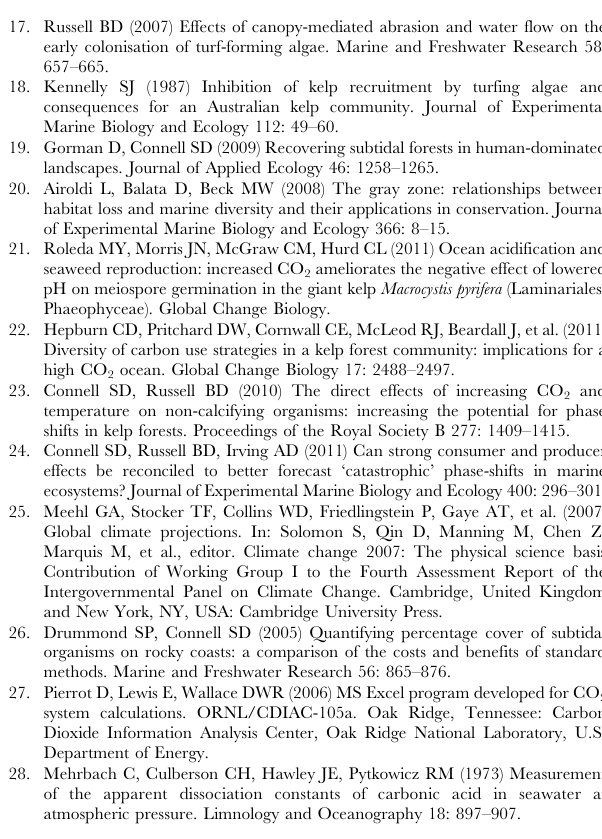
Figure S2 Carbonate chemistry parameters in field- based experimental mesocosms measured weekly from beginning to end of the experiment. pH (a), TA (b), p CO 2 (c), HCO 3 2 (d) in mesocosms under current CO 2 (filled circles) and future CO 2 (empty circles). Total Alkalinity (TA) and pH were measured weekly on eight occasions, from which concentrations ( m mol kg 2 1 ) of p CO 2 , and bicarbonate (HCO 3 2 ) were calculated. Values were calculated from measured TA and pH using constants from Mehrbach et al. [28], as adjusted by Dickson and Millero [29]. Data presented are means across different nutrient and kelp treatments. (TIF) Figure S3 A representative diurnal cycle (Oct 9–10, 2009; 0630-0630) of pH for all treatment combinations. CCO 2 , current CO 2 ; FCO 2 , future CO 2 ; KP, kelp present; KA, kelp absent; AN, ambient nutrients; EN, elevated nutrients.